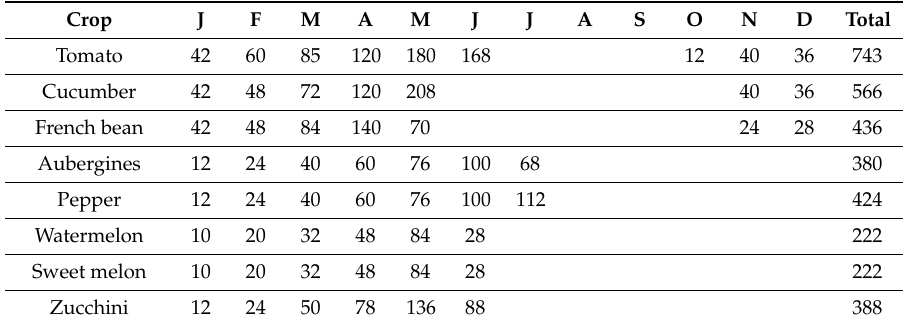
Table 3. Monthly and yearly estimated evapotranspiration requirements for several crops in protected cultivation (mm). Data adapted from